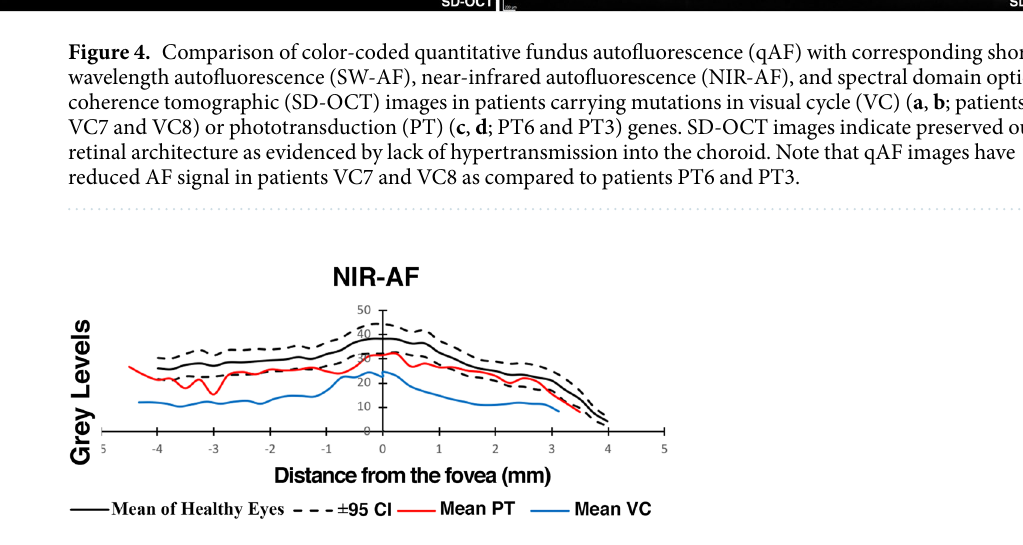
Figure 5. Semiquantitative analysis of near-infrared fundus autofluorescence (qNIR-AF) in patients carrying mutations in visual cycle (red line) (11 patients, 22 eyes) and phototransduction-specific (blue line) (5 patients, 10 eyes) genes. NIR-AF intensity profiles presented as mean grey levels are plotted as a function of temporal- to-nasal distance along a horizontal line (10 mm distance) through the fovea. Comparison is made to mean and 95% confidence intervals of healthy subjects (black lines) (19 controls, 38